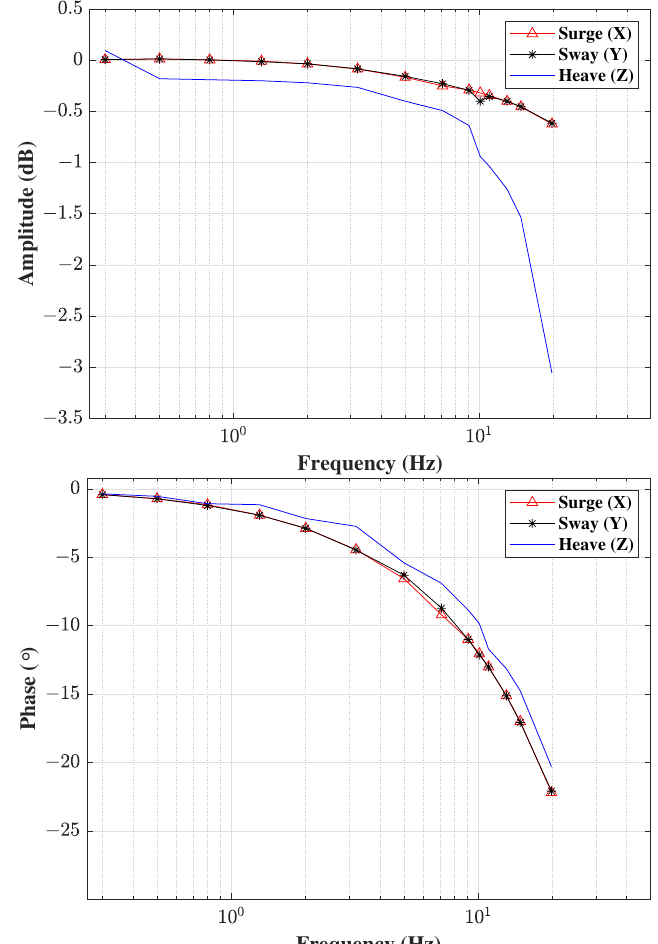
Figure 6. The Bode plot for a translational describing function under TSMC on SE(3).